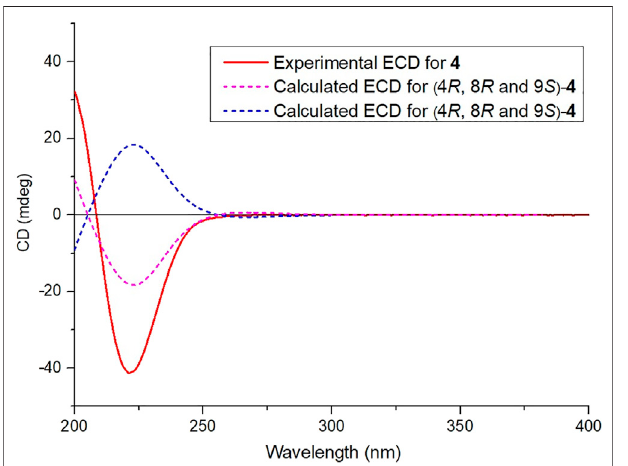
FIGURE 5 | Calculated and experimental ECD spectra of compound 4 .